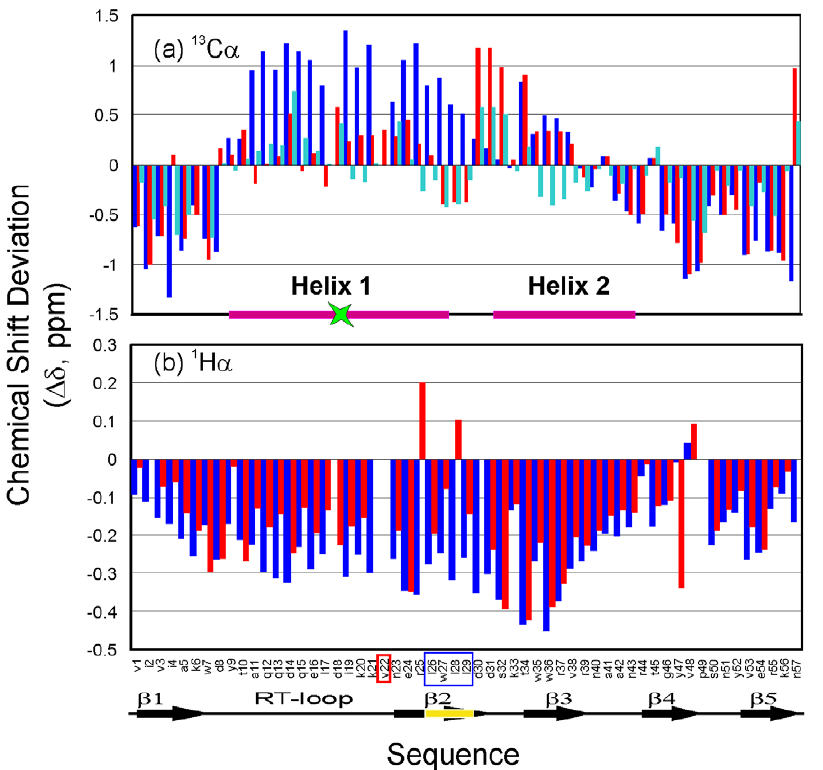
Figure 5. NMR chemical shift deviations. (a) Bar plot of C a chemical-shift deviations from their random-coil values for the V22-SH3 domain solubilized in salt-free water at pH 4.0 (red); wild-type at pH 2.0 (blue) and wild-type in the presence of 8 M urea (cyan). (b) Bar plot of H a chemical- shift deviations for the V22-SH3 domain solubilised in salt-free water at pH 4.0 (red) and wild-type at pH 2.0 (blue). Red box indicates the Val22 insertion while blue box indicates previously mutated region. Secondary-structure fragments are also indicated for both the native SH3 fold and non- native helical conformations previously observed [11].